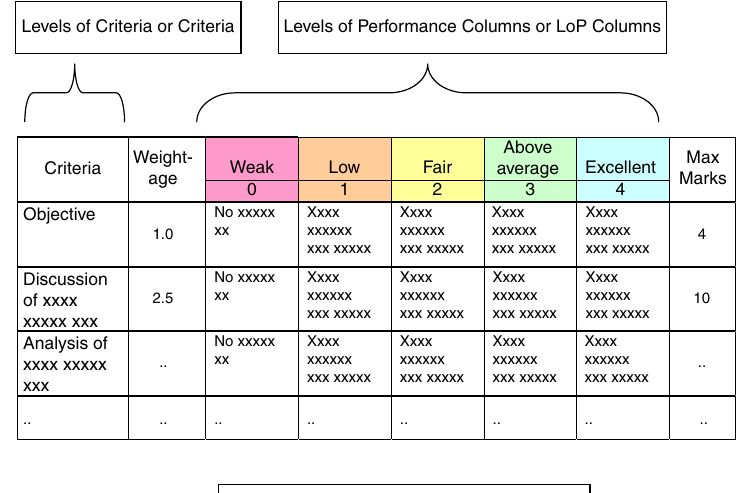
Figure 1. Structure of rubrics